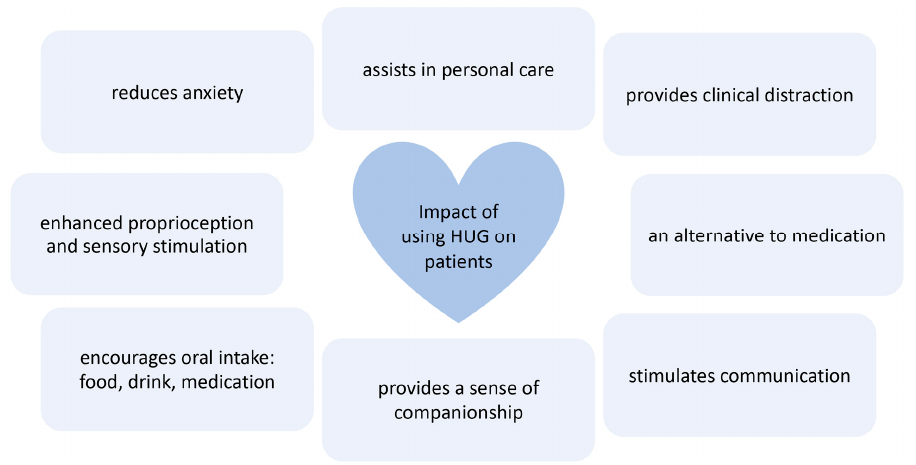
Figure 7. Findings: reported benefits of using HUG in an NHS hospital context.